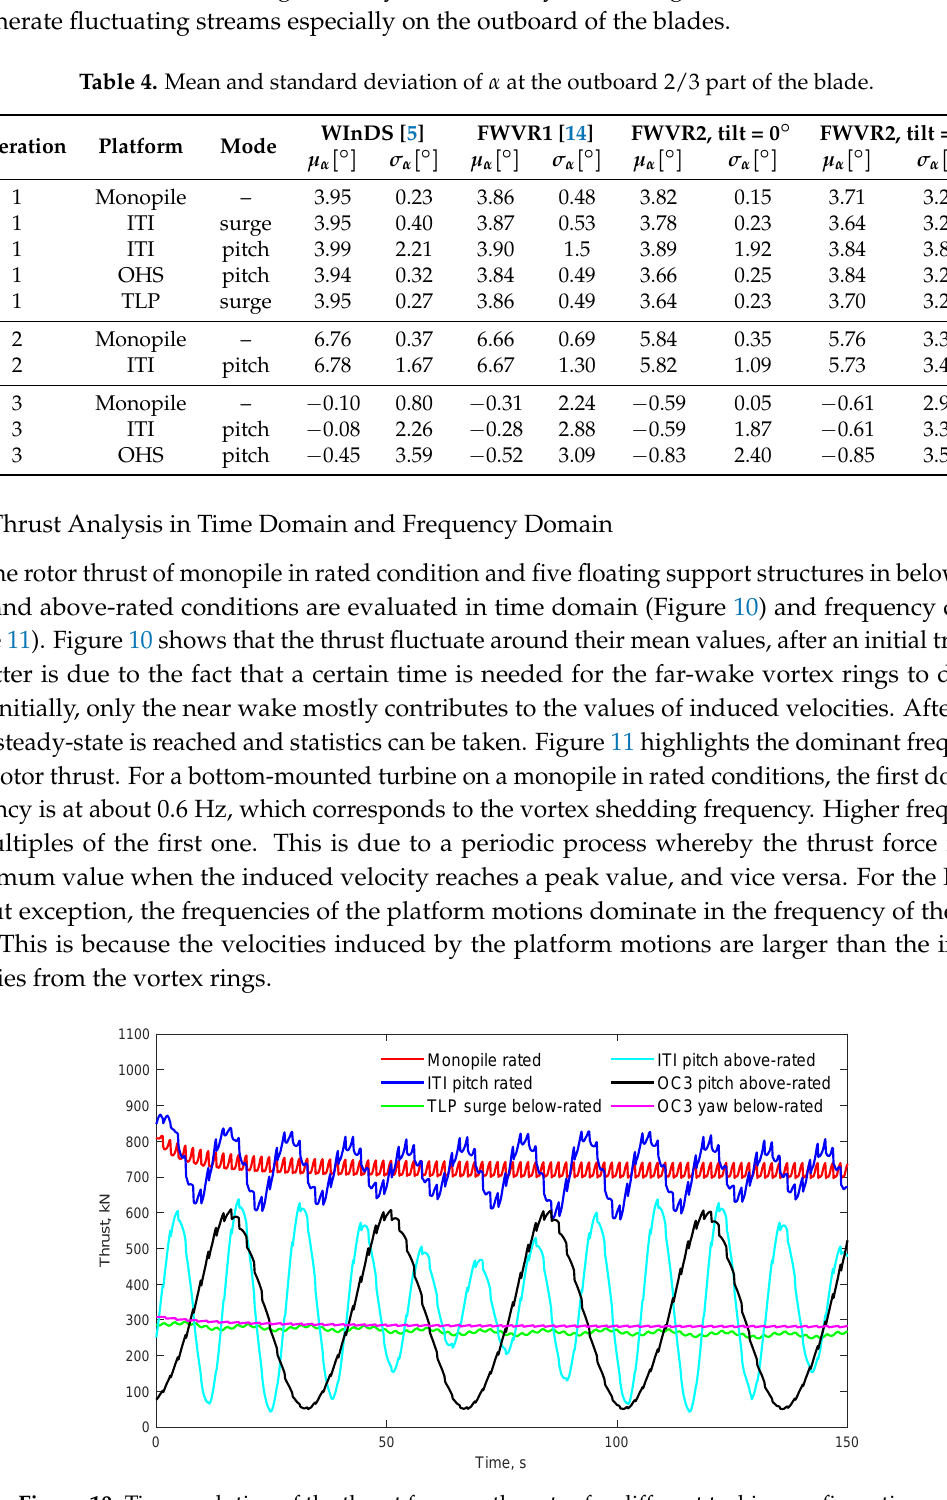
Figure 10. Time evolution of the thrust force on the rotor for different turbine